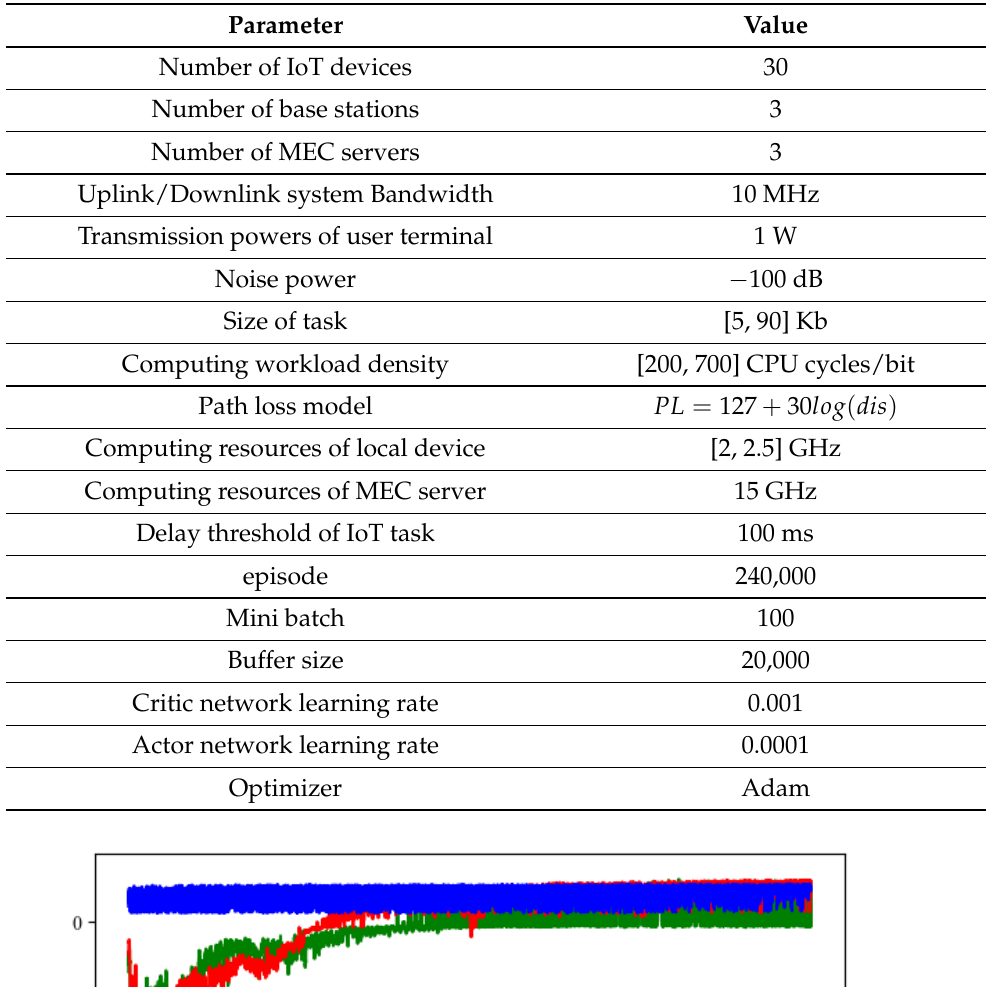
Table 2. Parameter descriptions.